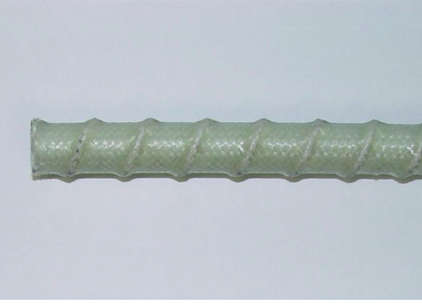
Figure 2: KICT GFRP bar